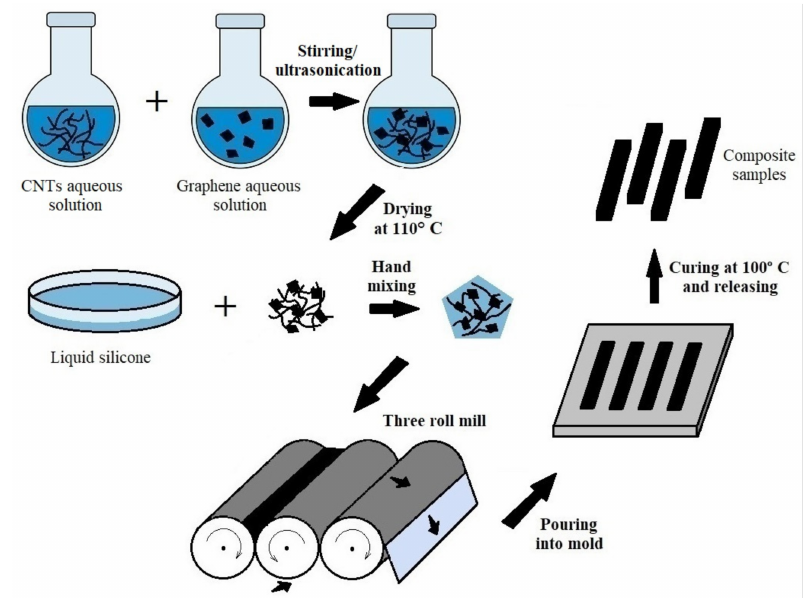
Figure 1. Schematic illustration of composite manufacturing